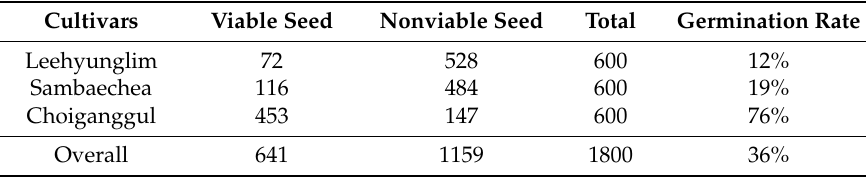
Table 2. Germination test result of the seed samples.